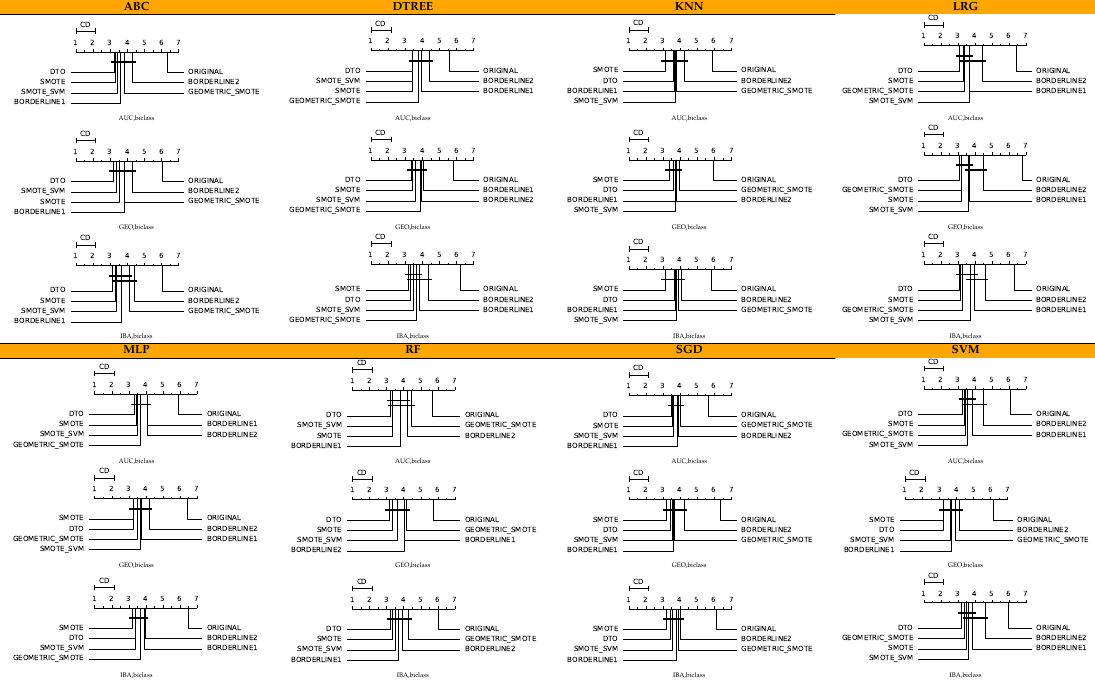
Table 5. Diagram of significance